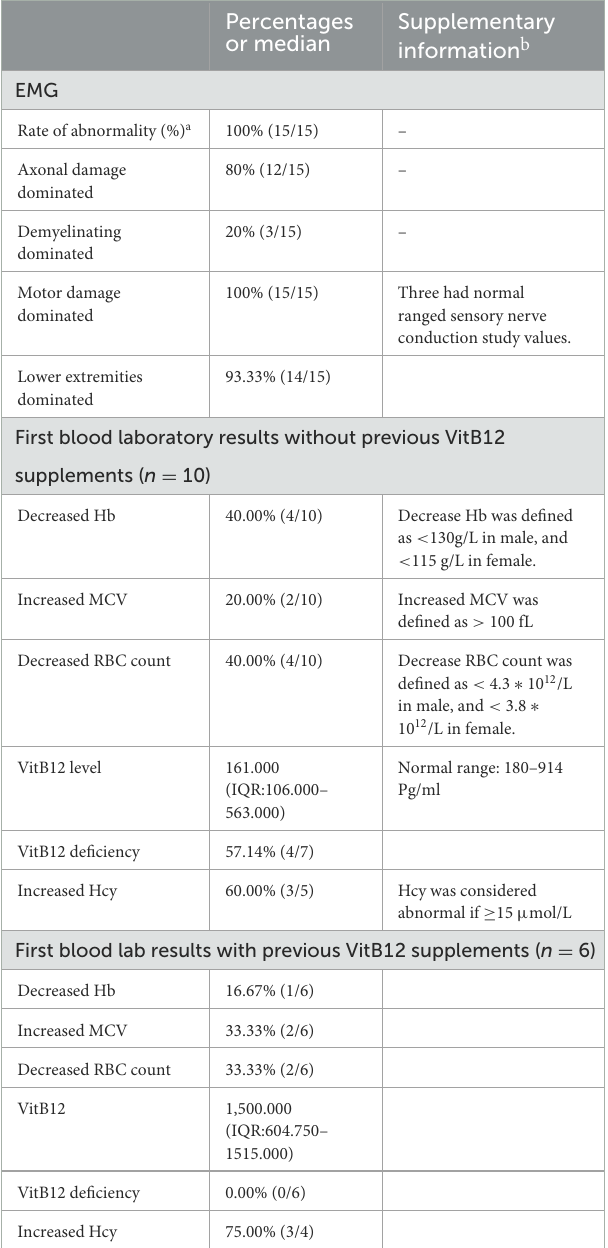
Percentages Supplementary or median information